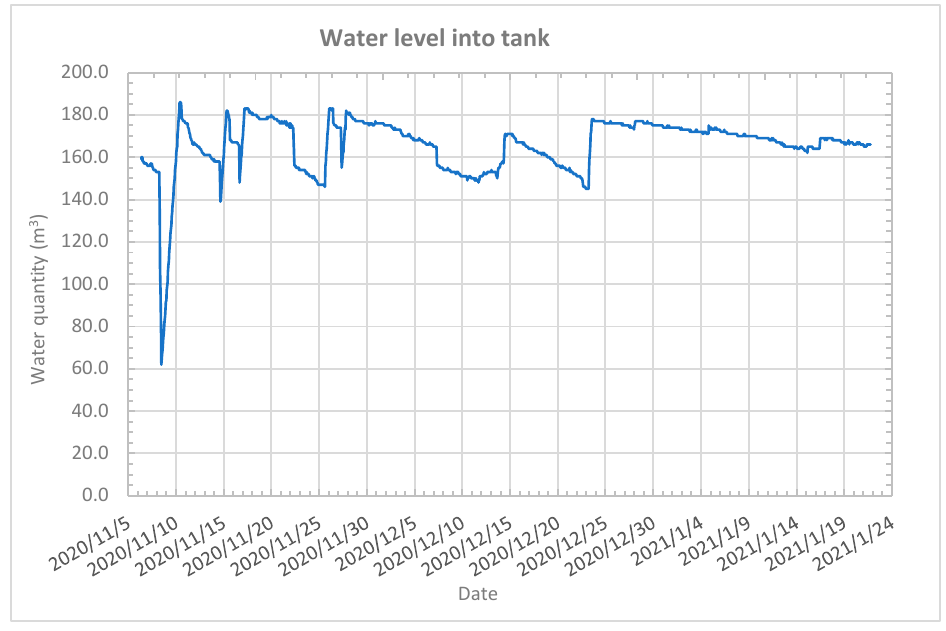
Figure 13. Monitoring of the water level in the roof tank.